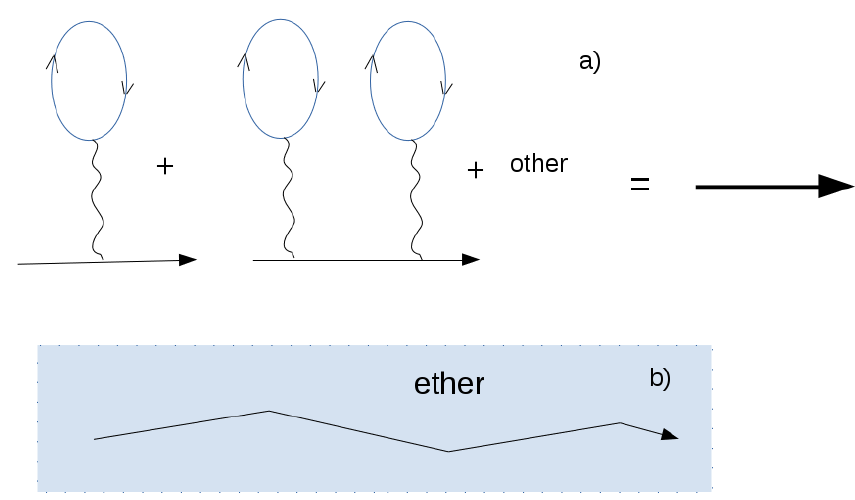
Figure 1. Illustration of vacuum influence on the particle propagation in ( a ) QFT, where the vacuum loops renormalize the mass and charge of the particle but do not prevent their free motion, and in ( b ) QG, where the æther fills space due to the absence of an invariant vacuum